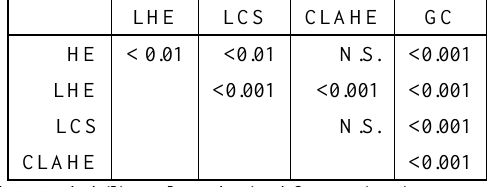
Table 5. Probability values obtained from pair-wise comparison of the BRISUE scores of output images (n = 36) generated by five image enhancement techniques. N.S.: Not significant. LHE divides the input image into blocks or tiles and redistributes the intensity level of the pixels by computing the histogram of each tile. Hence the overall contrast and edges of the image are enhanced even in the presence of noise, such as clouds (Figure 3). This resulted in lower BRISQUE scores and better overall performance by LHE method. However, this method is sensitive to the window size specified by the